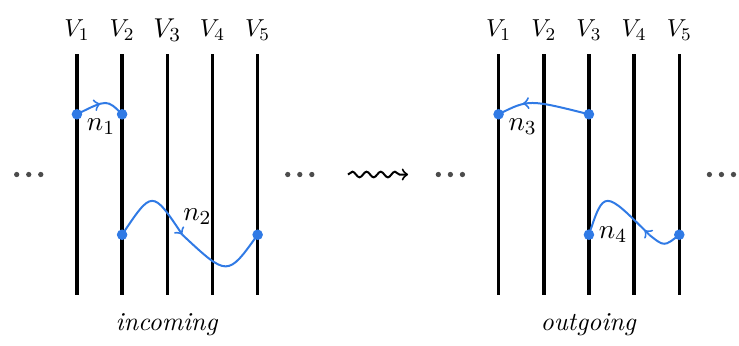
Figure 3 . The s -th D-brane in the array carries an electric gauge potential V s = sB/R , and the D-branes are separated by 2 π e R . Here, B denotes the value of the constant Kalb-Ramond field in the compact